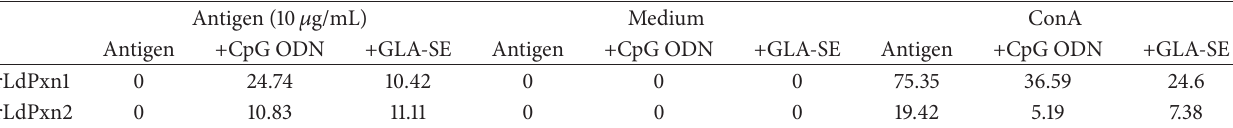
Table 1: The ratio of IFN- 𝛾 /IL-10 in lymph node cells of immunized